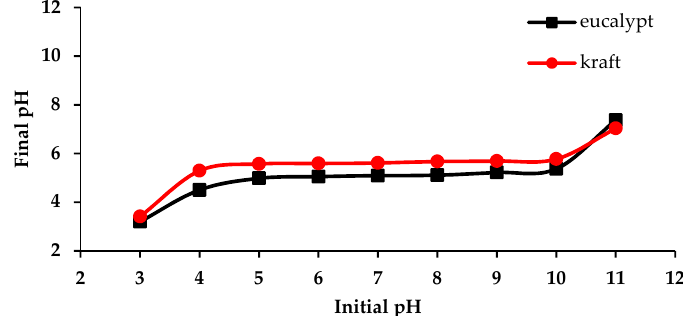
Figure 5. pH pzc curves for the eucalypt stump lignin and kraft lignin.